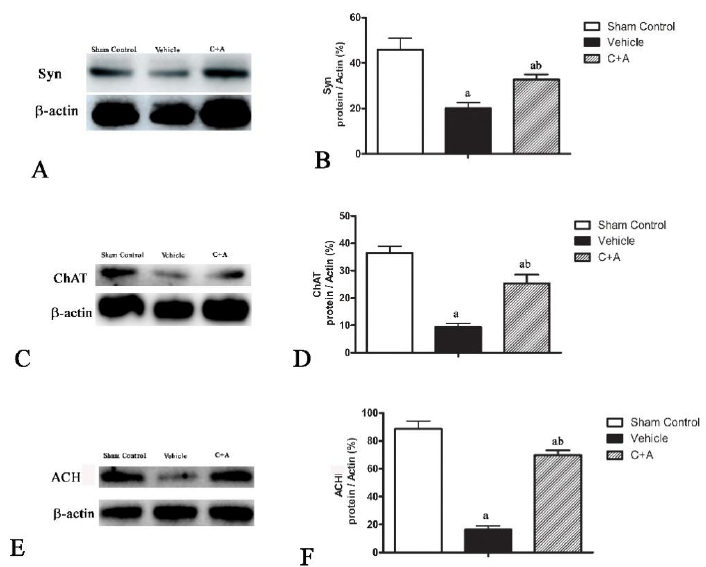
Figure 8. Western blot analysis of the expression of ( A , B ) synaptophysin (Syn), ( C , D ) choline acetyl- transferase (CHAT), and ( E , F ) acetylcholine (ACH) in all three experimental groups. ( B , D , F ) Semi- quantitative profiles of protein bands showed that the C16 + Ang-1 treatment restored the down- regulation of Syn, CHAT, and ACH in the vehicle group. a, p < 0.05 vs. sham control group; b, p < 0.05 vs. vehicle group. Molecular weight (MW): Syn, 38 KD; CHAT, 83 KD; ACH, 146KD; β -actin, 42 KD.